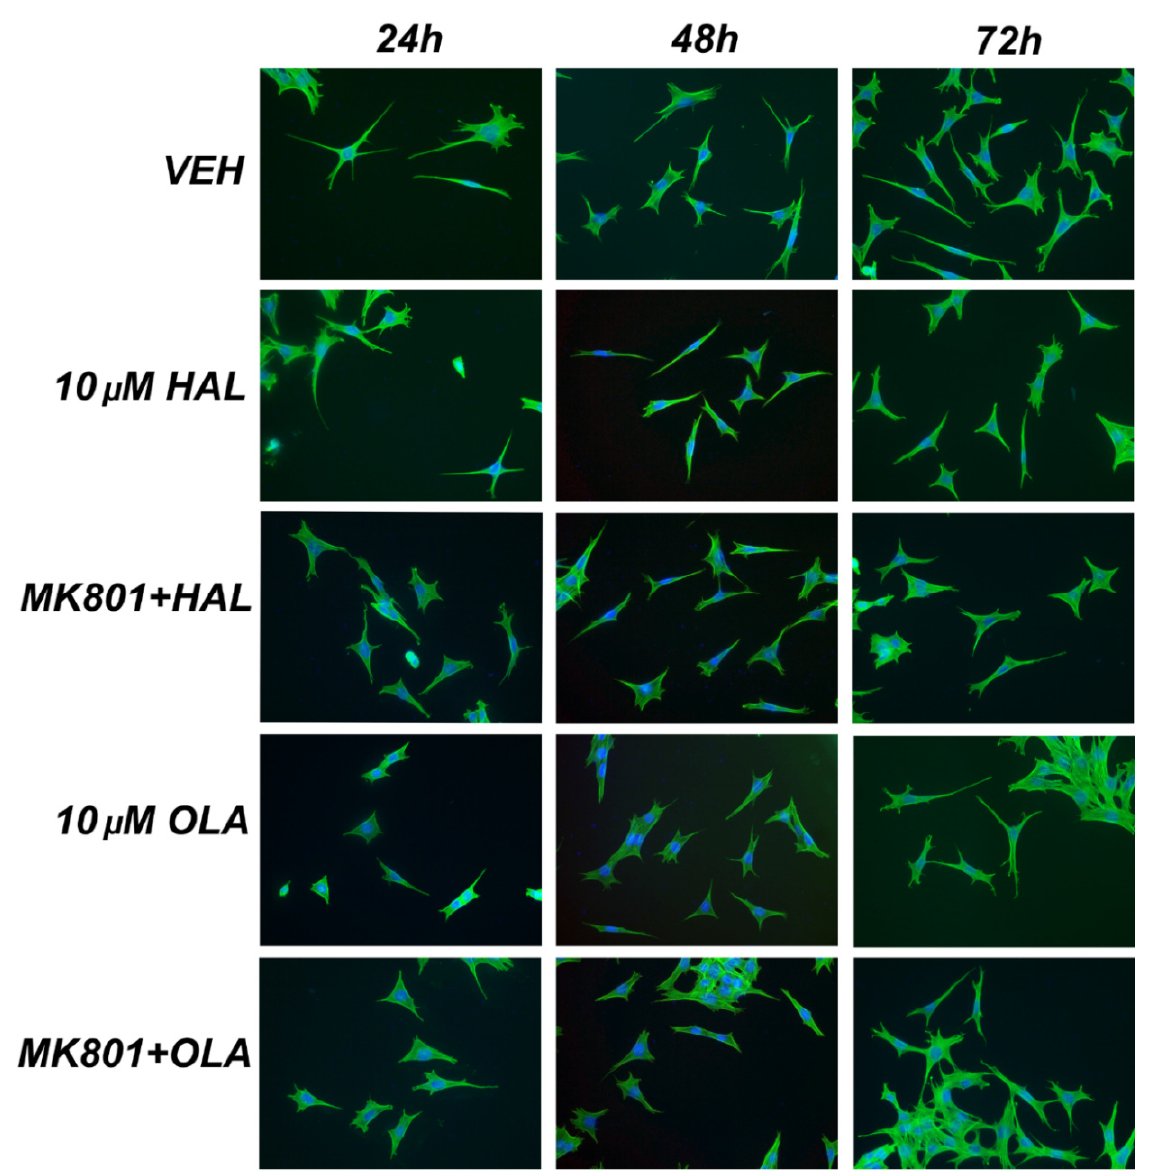
Figure 2. Representative fluorescent microscopic images of mHippoE-2cells after 24 h, 48 h, and 72 h incubation with vehicle, 10 µM HAL/OLA, and 20 µM MK-801 + 10 µM HAL/OLA. Double immunofluorescence for nuclei stained by DAPI (blue) and actin filaments stained by phalloidin-iFluor (green). Magnification × 400.